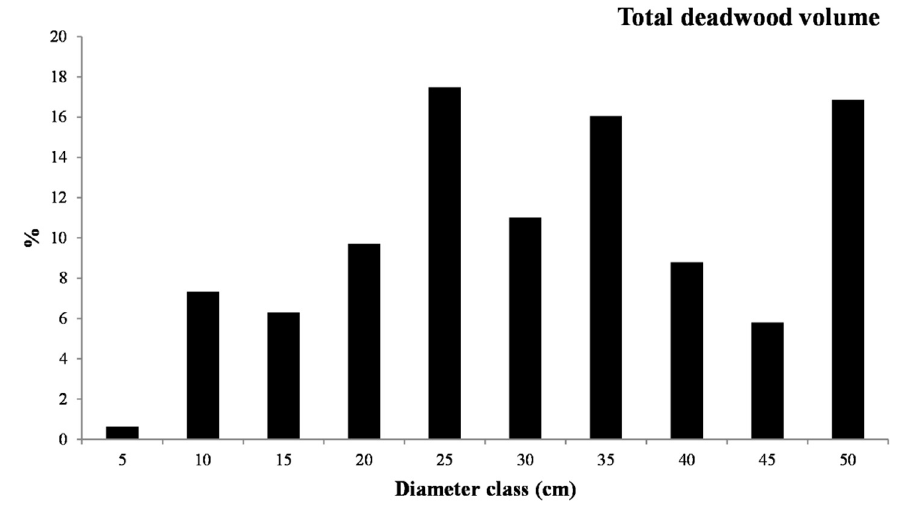
Figure 9. Total deadwood volume percentage distribution according to mean diameter.